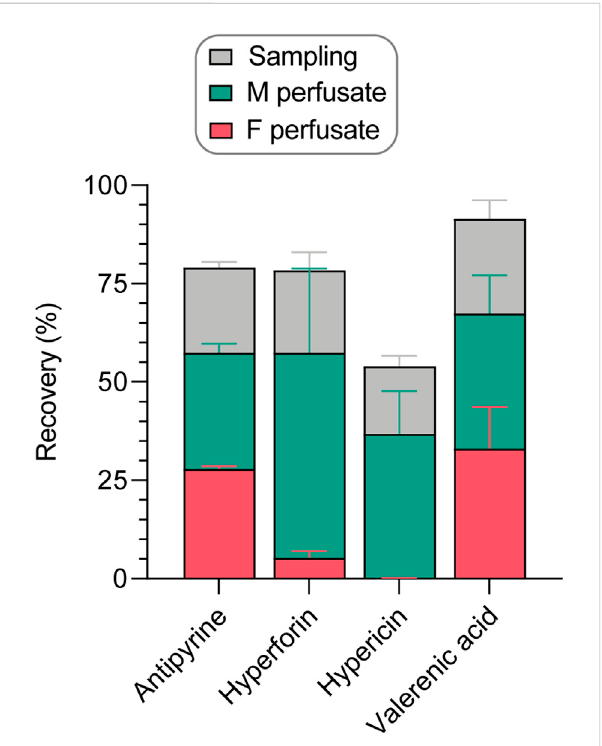
FIGURE 5 Recovery of study compounds in the human ex vivo placental perfusion system, expressed as percentage (%) of amount analyzed in the maternal sample at the beginning of the perfusion. The fi nal recoverywascalculatedasthesumofcompoundpresentinfetal and maternal perfusates at the end of a perfusion, and the amounts sampled during the perfusion from fetal and maternal perfusates (Supplementary Table S1). All data are represented as mean ± SD of three to four independent